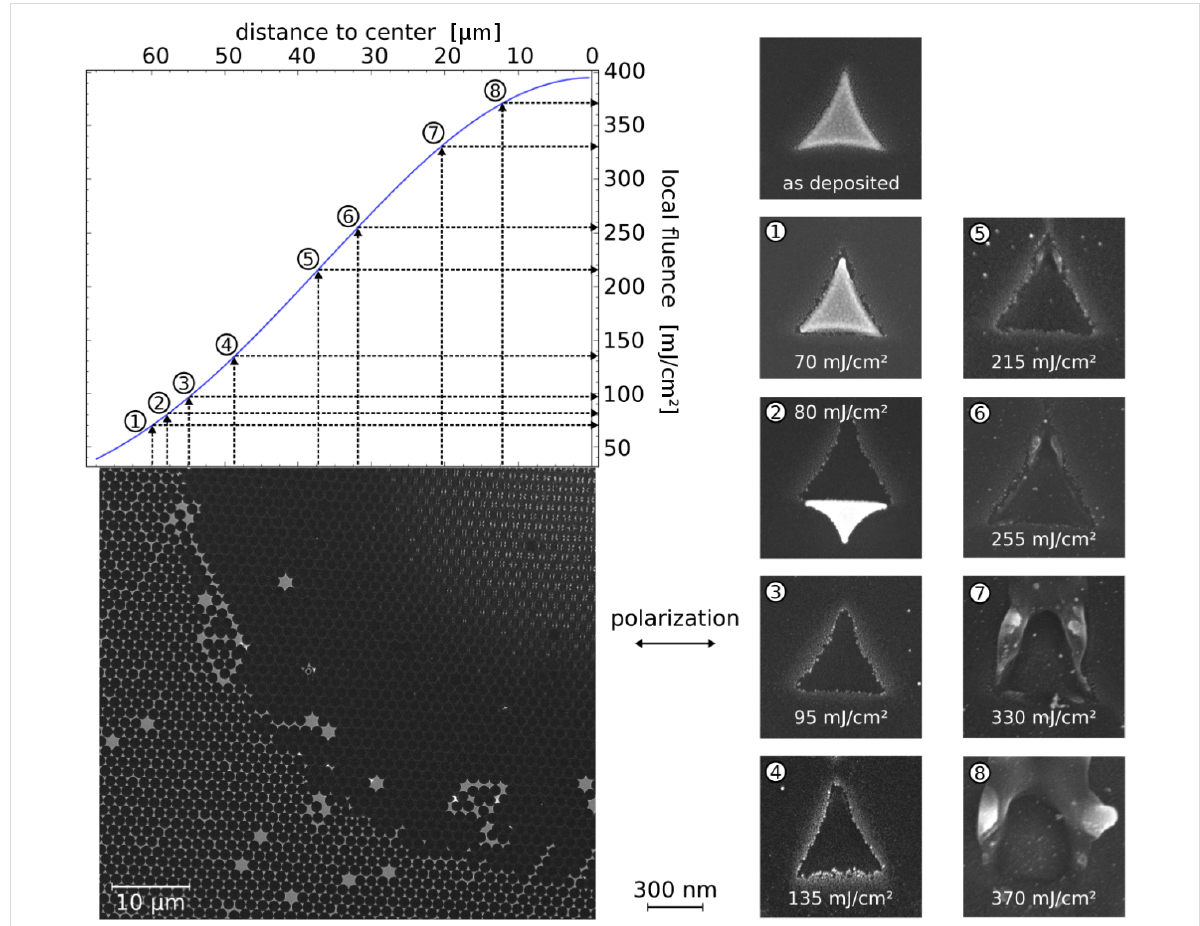
Figure 5: Upper left: Fluence distribution along the laser spot radius as described in the Experimental section. Lower left: SEM picture of one quad- rant of an ablation pattern of gold triangles irradiated with a 150 fs laser pulse. The triangles were produced by colloid lithography using spheres with a diameter of 1.55 µm and had a side length of about 530 nm. Right: Detailed blow-ups of triangles and the Si surface in different states of modifica- tion. The radial position of each blow-up is marked in the fluence distribution. It has to be noted that the triangles exhibit two different modes, depending on the polarization of the exciting light. Thus two different ablation patterns can be observed. In this figure patterns for a polarization parallel to the edge of the triangle are shown. A comparison of the two different modes can be found in Figure